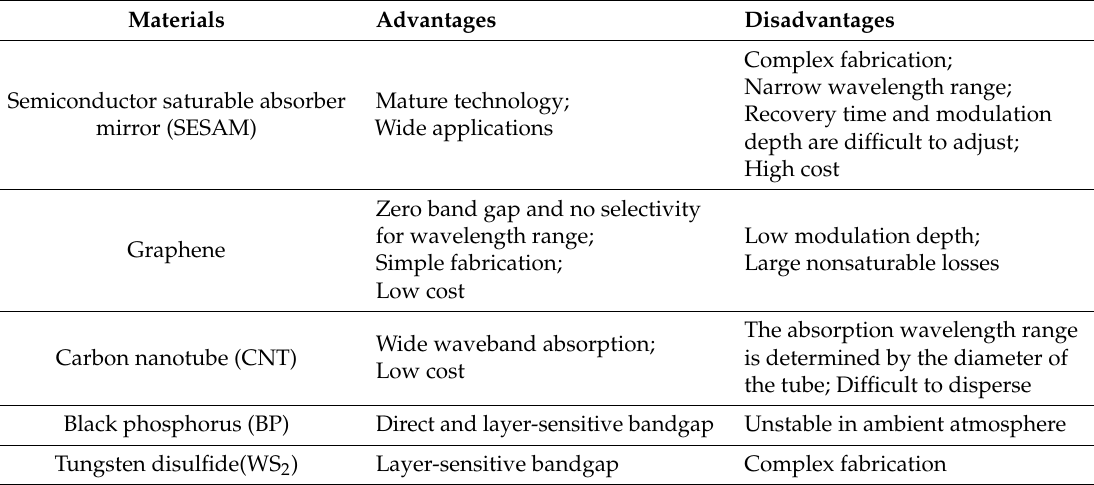
Table 1. The pros and cons of some typical saturable absorber (SA)